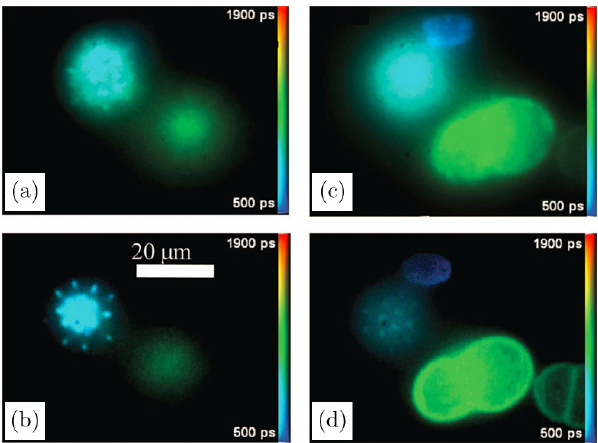
Fig. 6. Conventional FLIM images of pollen grains from a gated image intensi¯er (a), (c) and images obtained by the same image intensi¯er with optical sectioning by a Nipkow disk (b), (d). Eight time gates, total acquisition time 4s. Adapted with permission from Ref. 107, OSA